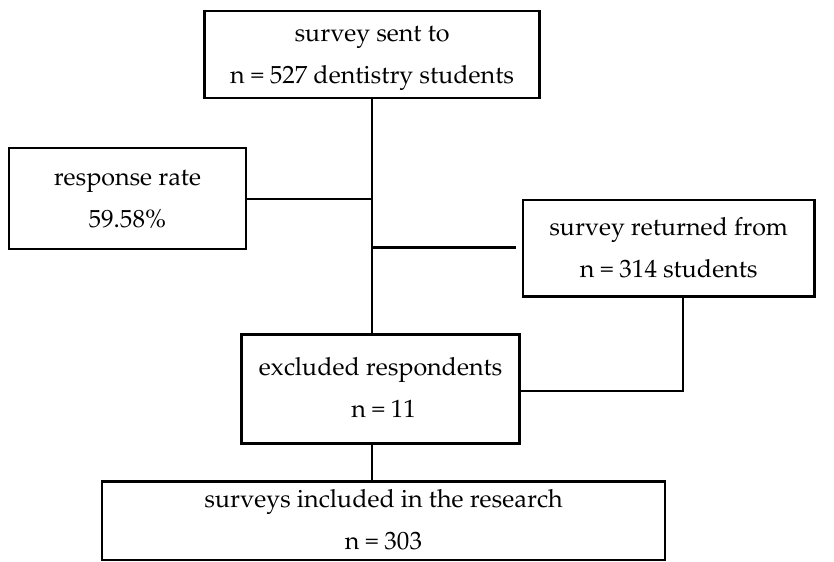
Figure 1. Study profile.